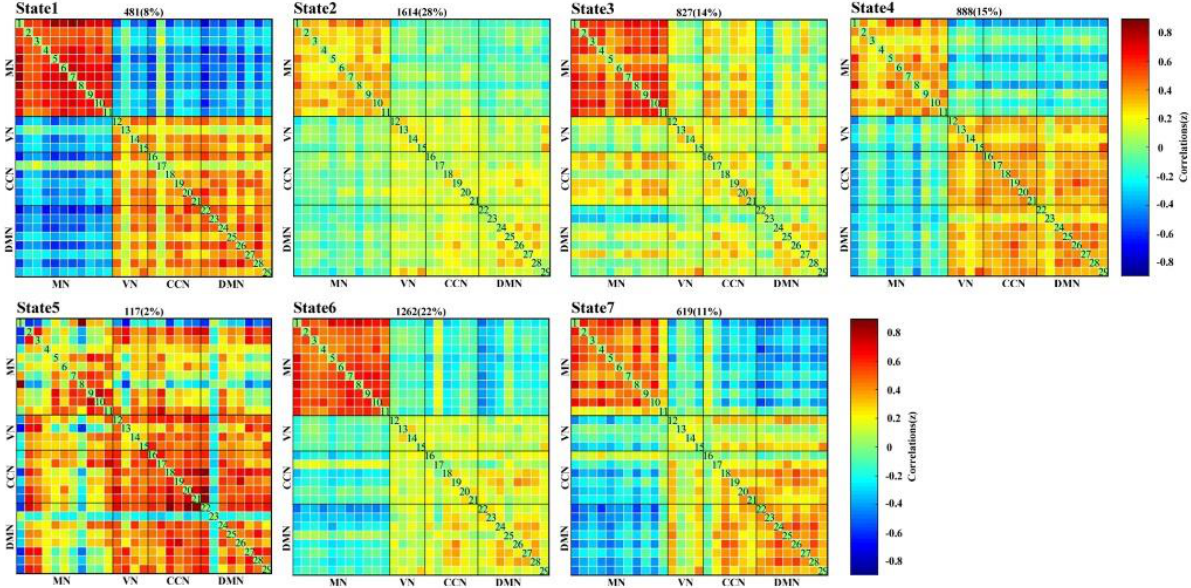
Figure 3. The median pattern of 7 FC states in motor execution tasks run clustered by K-means. The total number and percentage of occurrences is listed above each FC pattern.